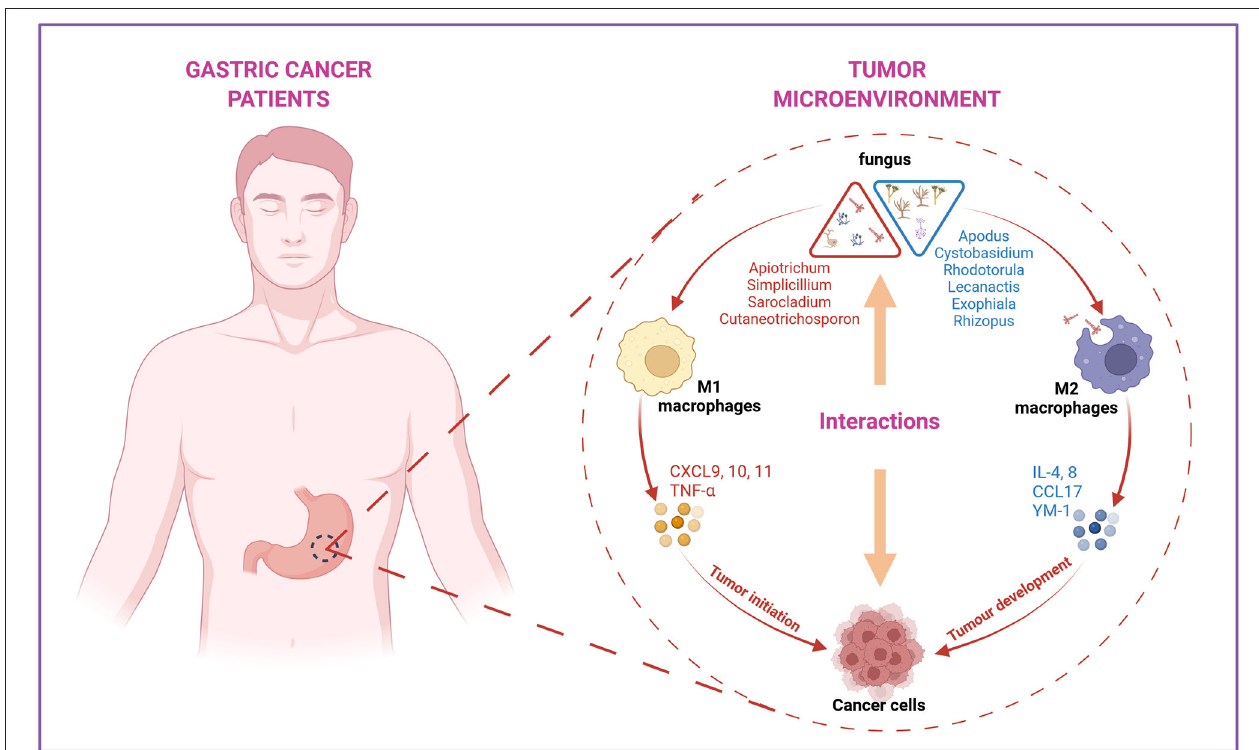
FIGURE 7 | The summary of the interactions between specific fungus with immune factors in the tumor microenvironment during the progression of GC. Apiotrichum , Simplicillium , Sarocladium , and Cutaneotrichosporon were positively correlated with M1 macrophages-related pro-inflammatory factors, such as CXCL9, 10, 11 and TNF- α , indicating these four fungi may involve in the initiation phase of tumor development. Cystobasidium , Apodus , Lecanactis , Rhizopus , Rhodotorula , and Exophiala were found to be positively correlated with M2 macrophages related anti-inflammatory factors IL-6, IL-8, CCL17 , and YM-1 , suggesting these genera may participate in the progression after tumor formation. Created with